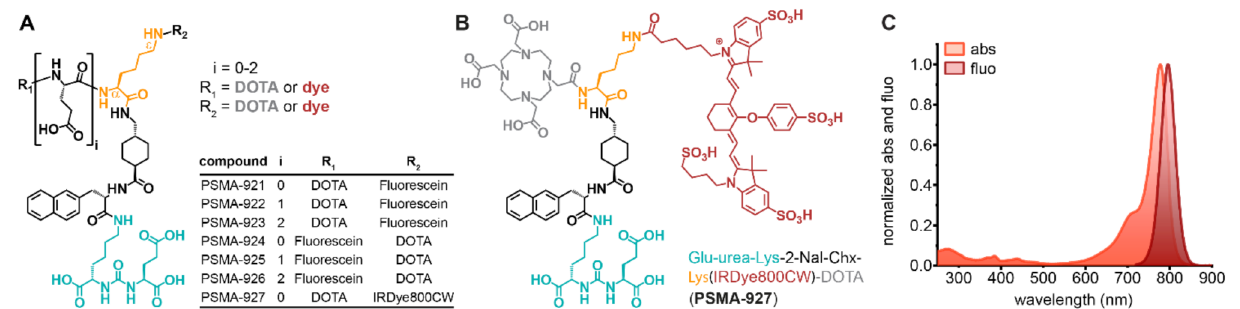
Figure 1. Chemical structures and spectral properties of PSMA-617-based hybrid molecules. ( A ) Generic structure with a lysine branch (orange), glutamic acid linker moieties (i = 0–2), and fluorescent dye (red) and DOTA (gray) conjugated as R 1 or R 2 . ( B ) The lead candidate of the molecule library consists of the PSMA-binding motif “Glu-urea-Lys” (cyan), the radiometal chelator “DOTA” (gray), and the fluorescence moiety “IRDye800CW” (red) conjugated via a “2-Nal-Chx-Lys” linker moiety (black and orange). ( C ) Absorption and emission spectra of PSMA-927 peaking at 778 and 796 nm,